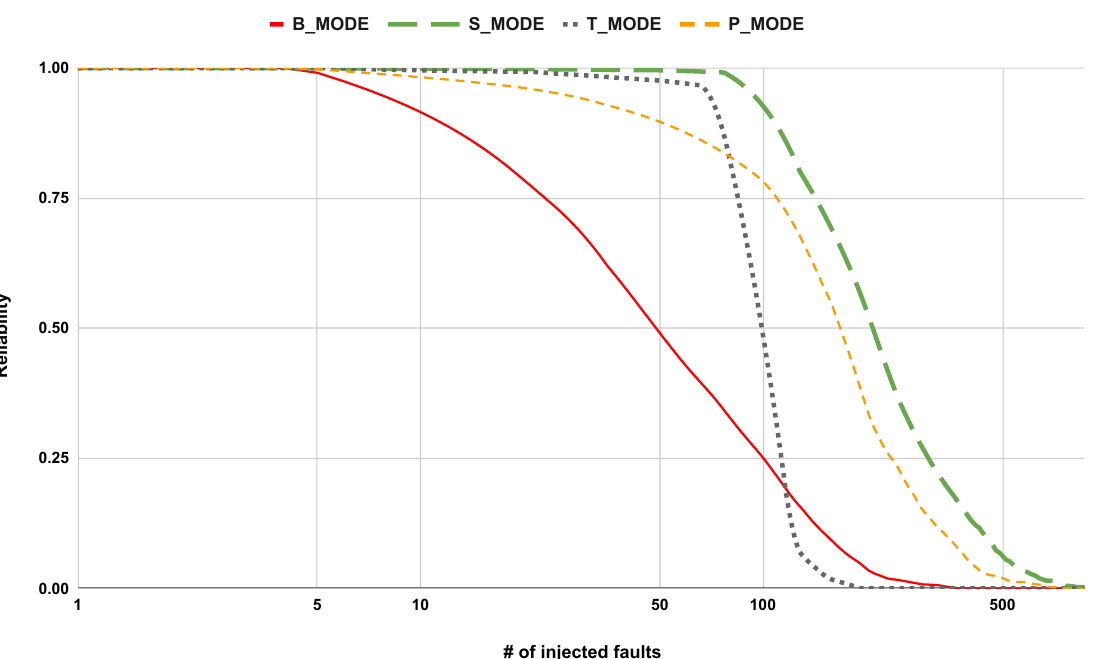
Figure 9. System reliability at 100 ms injection